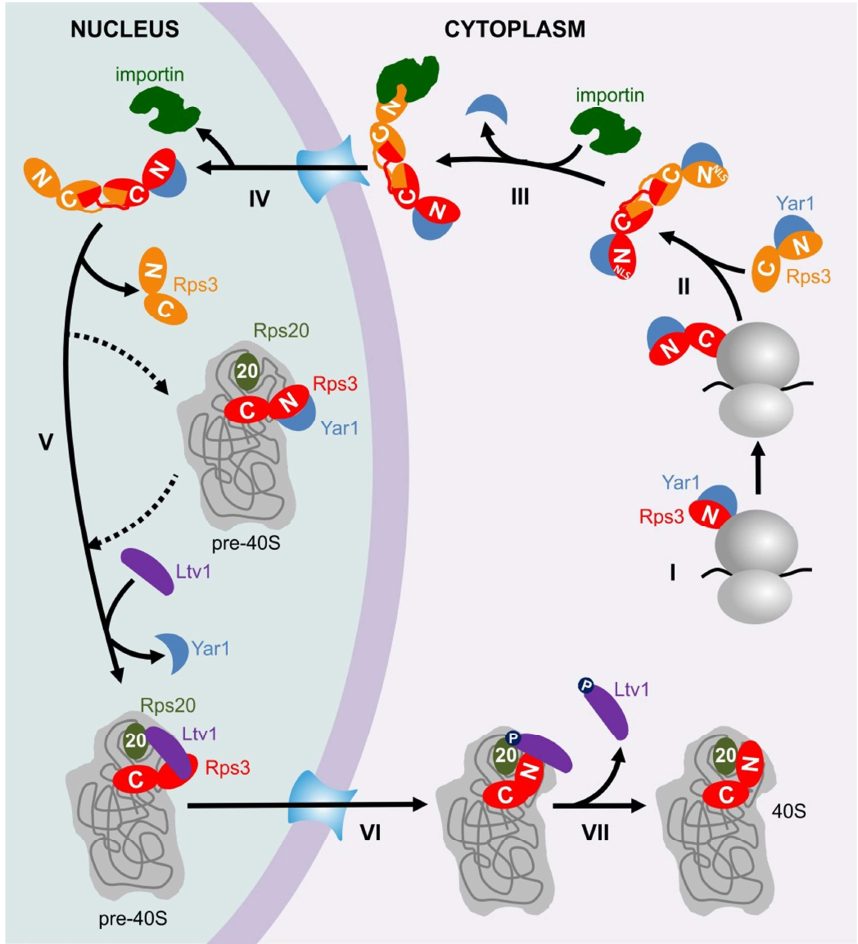
FIGURE 1: The ribosome assembly path of Rps3. I. The N-domain of Rps3 is co- translationally bound by the chaperone Yar1. II. The C-domain of Rps3